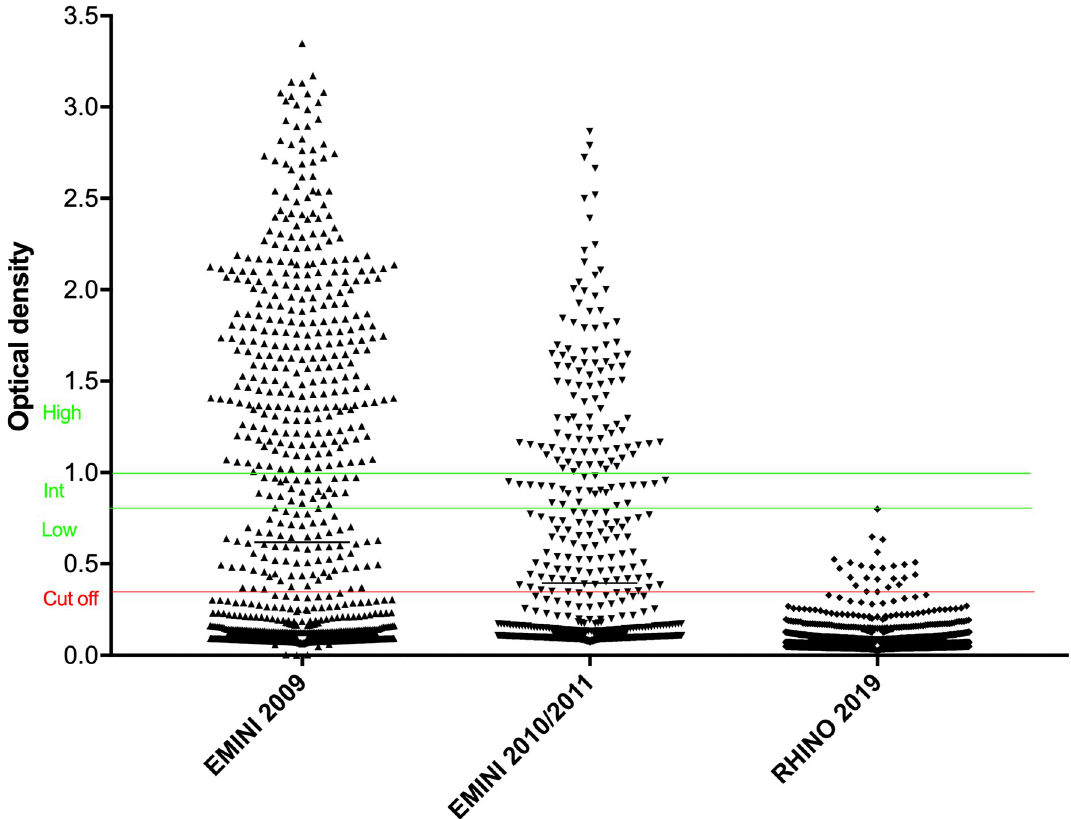
Fig 3. OD values of the TropBio ELISA of plasma samples from individuals 14 to 65 years of age are shown. The TropBio ELISA is measuring the circulating filarial antigen of the adult filarial worm. Values above OD 0.35 are considered as positive, with low positive results between OD 0.35 and 0.8, intermediate positive results between OD 0.8 and 1.0, and high positive results above the OD of 1.0. Most filarial infected individuals in 2009 showed high positive results, reflecting a high adult worm burden. In 2019 infected individuals had low positive ODs indicating a low number of adult